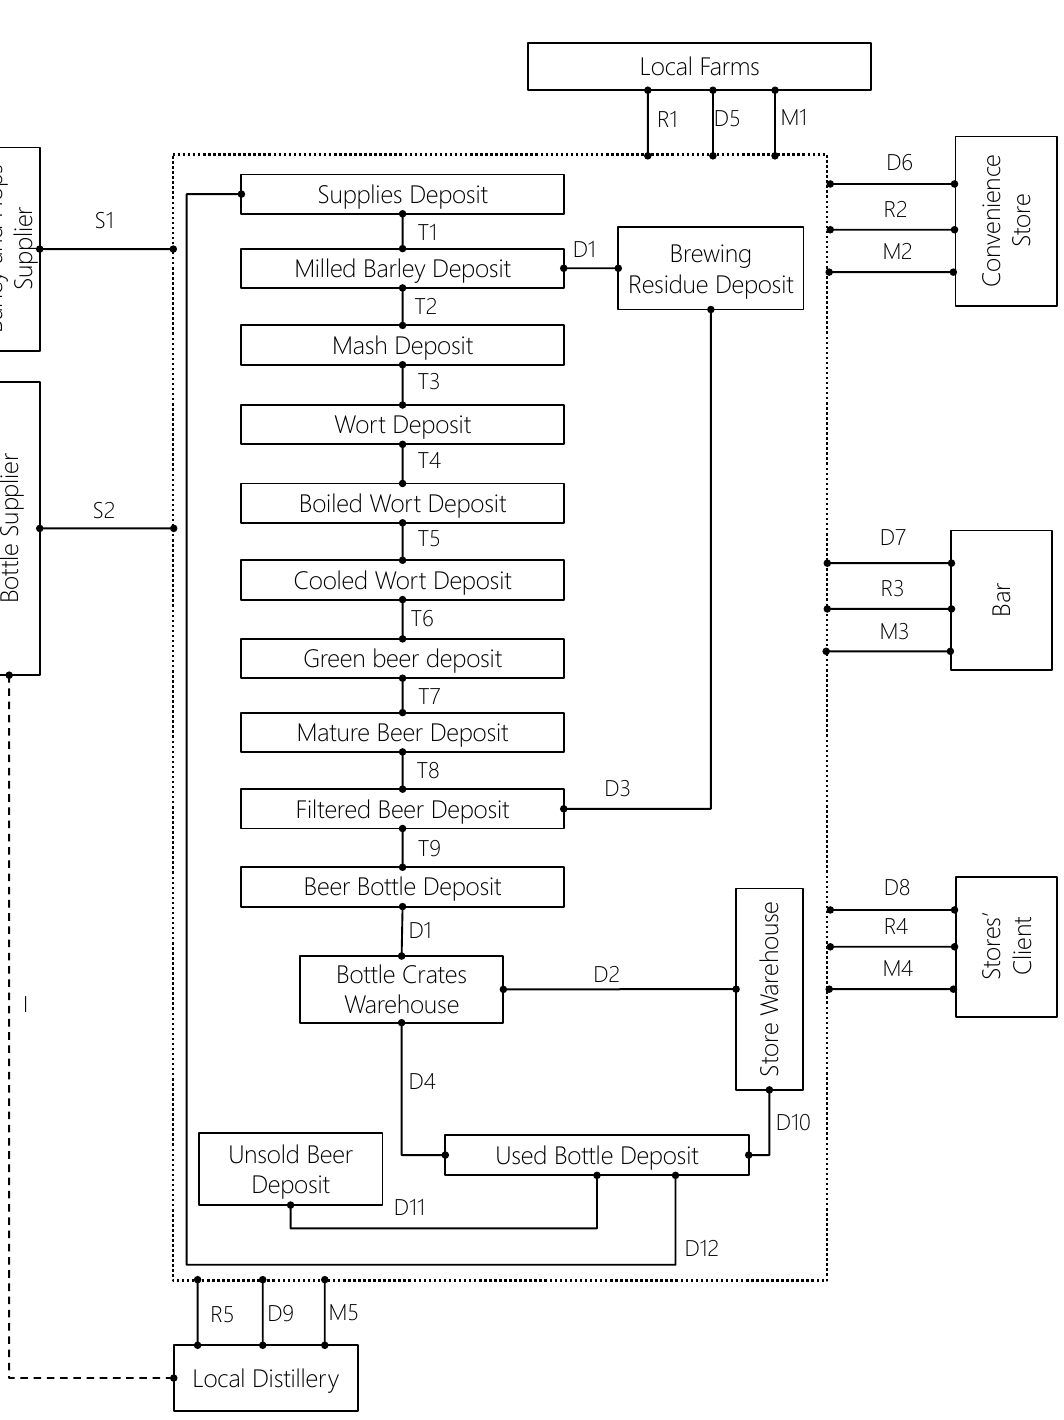
Figure 15. Alps Brewery Business Model